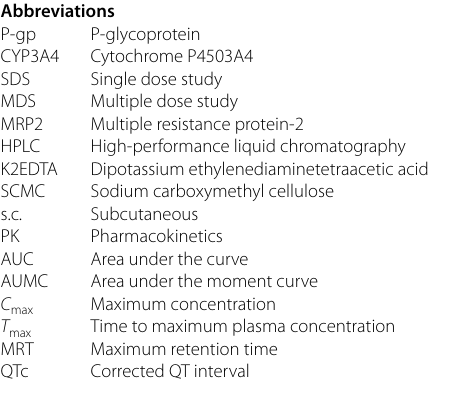
Fig. 6 The movement of ranolazine in the rat-everted ileum from the serosal to mucosal side in the presence and absence of verapamil (n ranolazine; V,